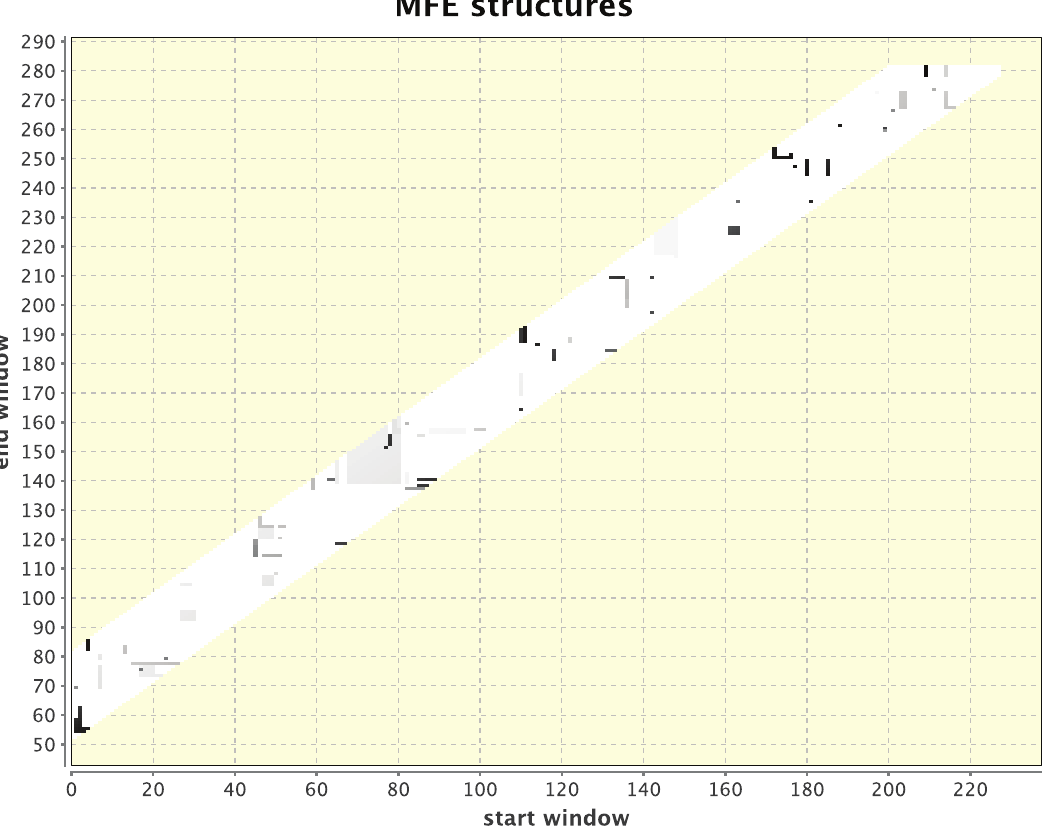
Figure 4. Simulated heat-shock response for a control sequence in the vicinity of the E.coliibpA RNA thermometer, but not containing the thermometer itself. No clustering of dots that may indicate a potential RNA thermometer is observed.